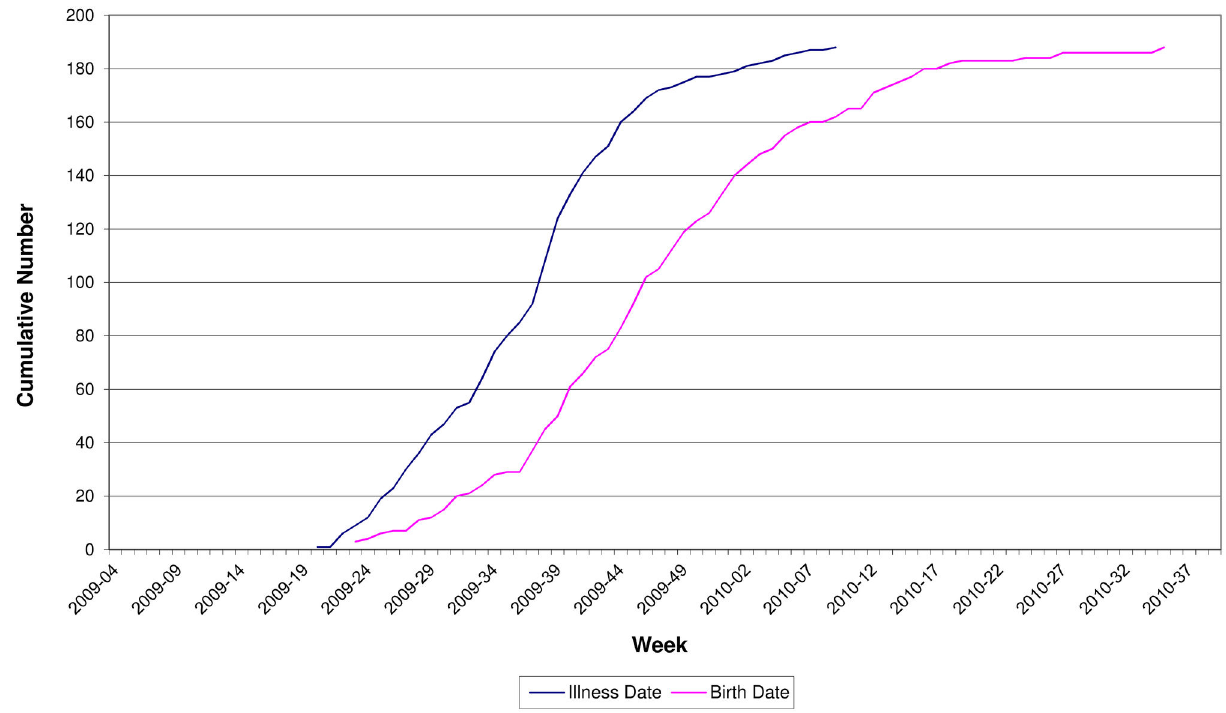
Figure 2. Cumulative pandemic influenza illness in pregnant women by illness and delivery date. doi: